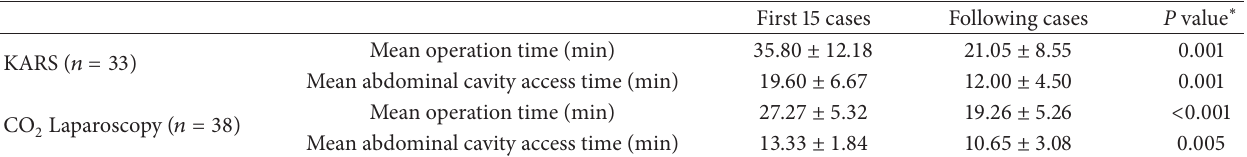
Table 3: The comparison of the first 15 operations with the later operations in both surgical techniques. The data was presented with mean ± standard deviation